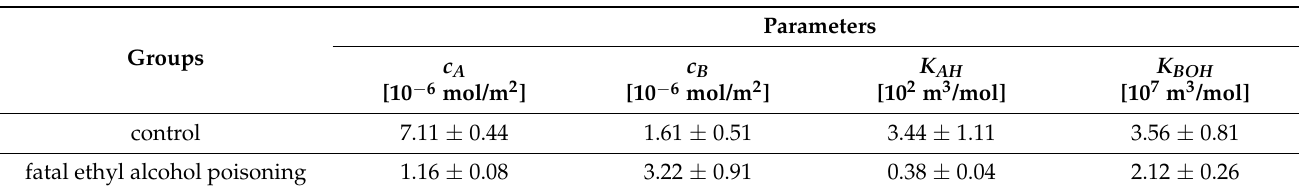
Table 3. The acidic and basic total concentrations of functional groups of erythrocytes and their association constants with H + and OH − ions.